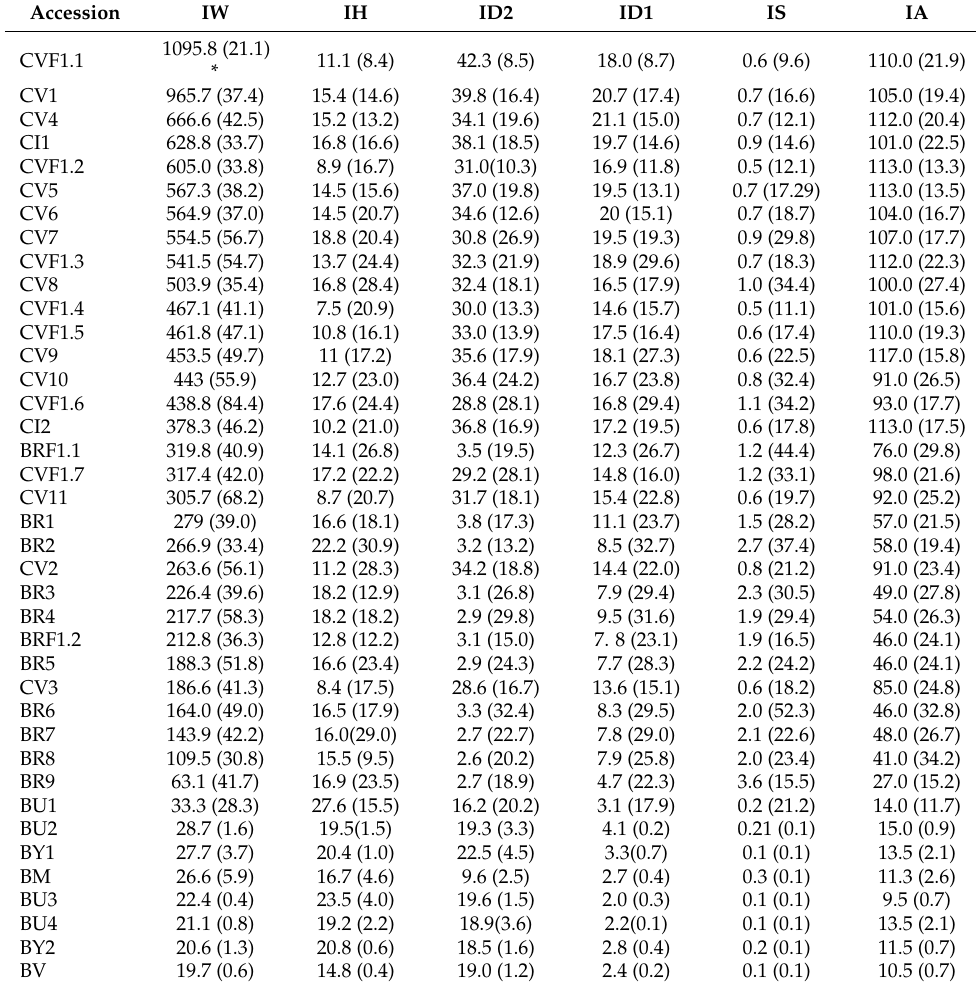
Table 1. Inflorescence morphometric traits